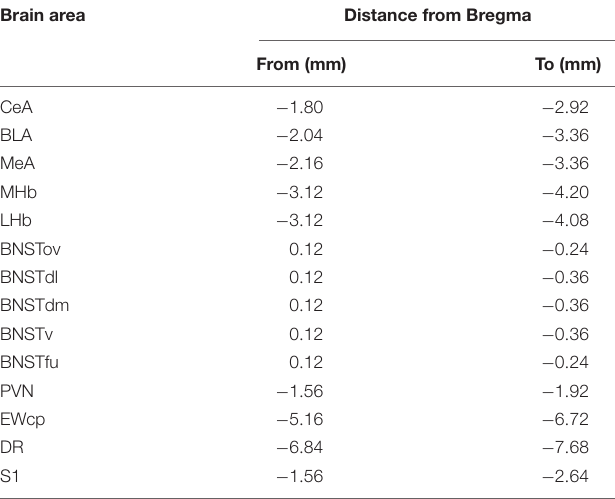
TABLE 1 | List of examined brain areas and their distance from Bregma in mm. Brain area Distance from